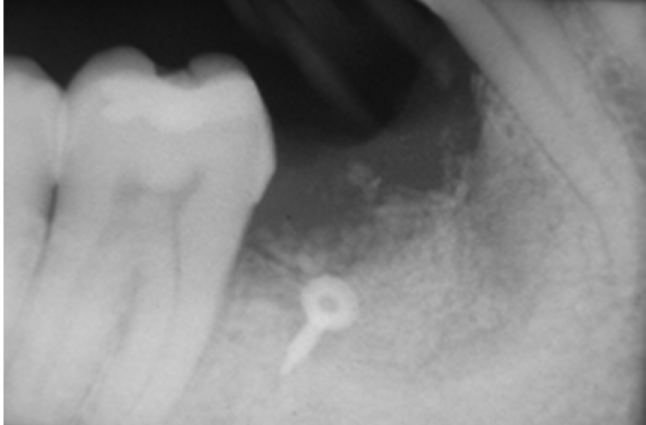
Figure 4. Post-operative Rx showing bone defect correction.